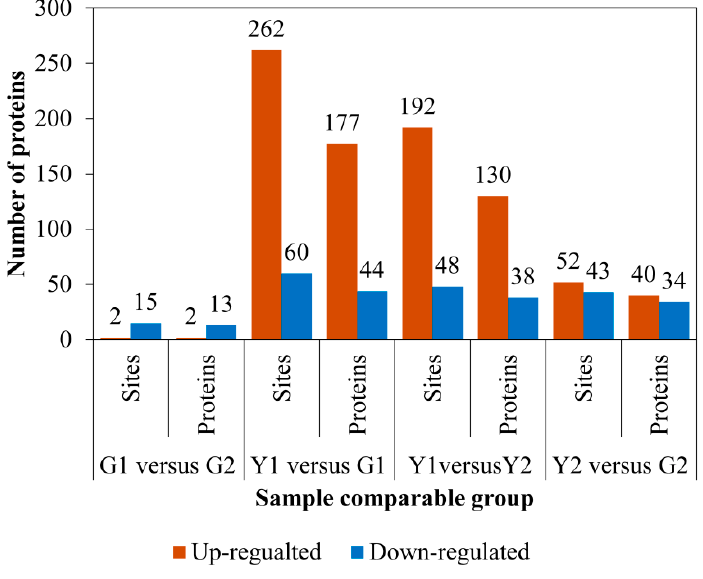
Figure 5. Numbers of phosphorylated proteins and sites in the G1 versus G2, Y1 versus G1, Y1 versus Y2, and Y2 versus G2 comparisons.